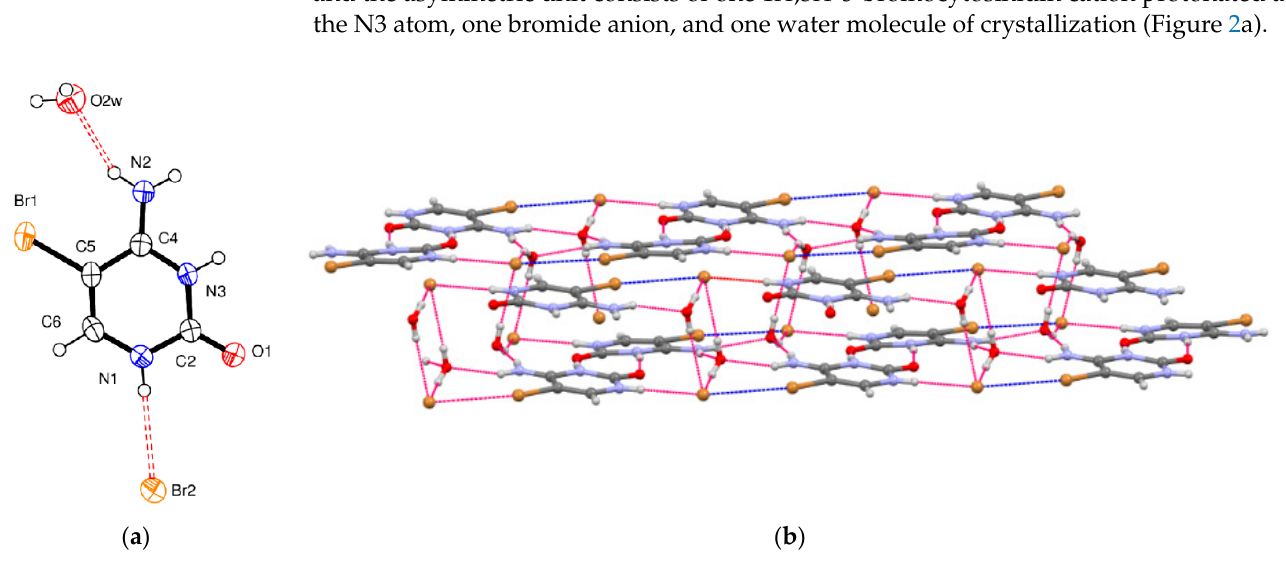
Figure 2. ( a ) The asymmetric unit of compound ( II ), showing the adopted atom-numbering scheme. Displacement ellipsoids are at the 50% probability level. H atoms are shown as small spheres of arbitrary radii. Hydrogen bonding is shown as red dashed lines. ( b ) Part of the crystal structure of ( II ). All atoms are shown as small spheres of arbitrary radii. Hydrogen bonding is shown as red dashed lines. Halogen bonding is shown as blue dashed lines.